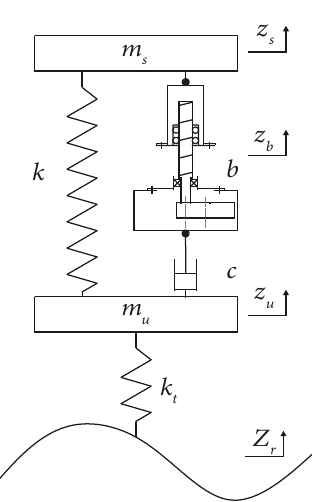
Figure 3: The vehicle ISD suspension model with parallel-con- nected eccentric